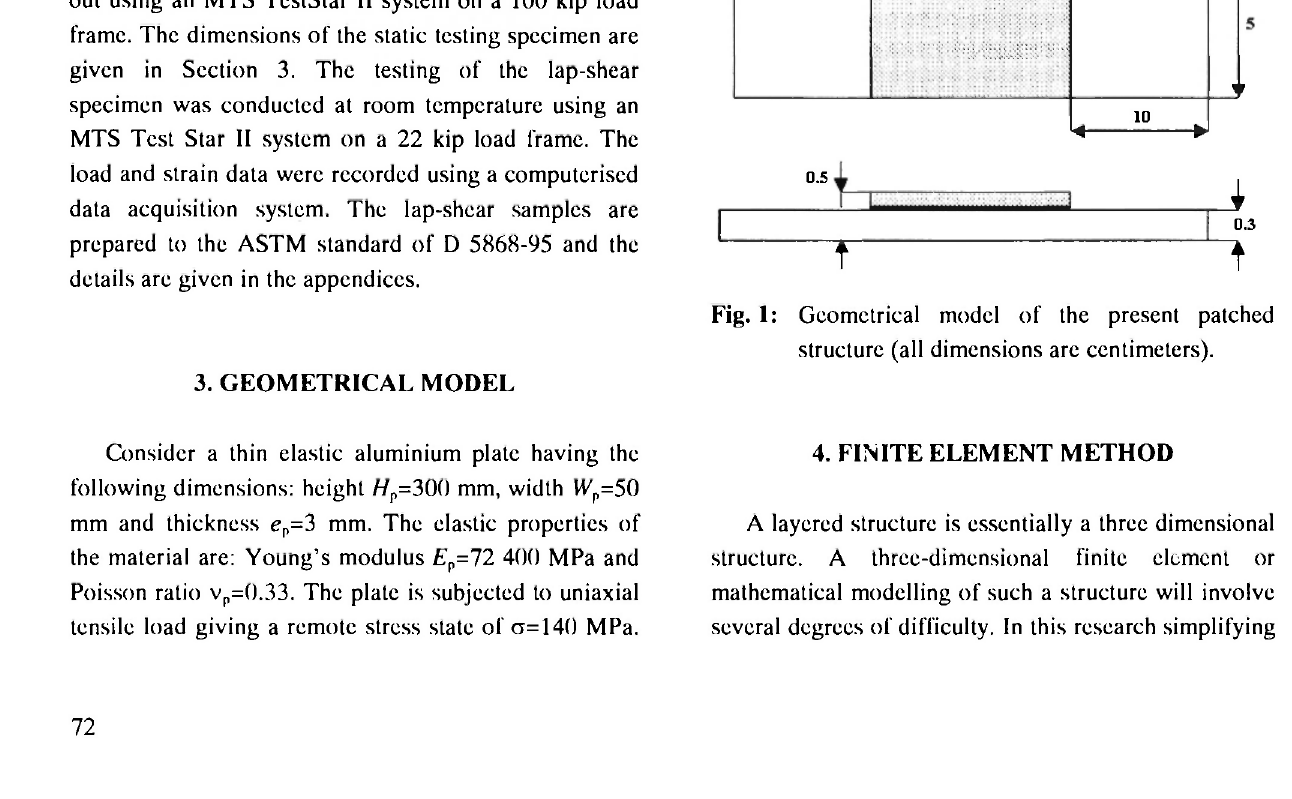
Fig. 1: Geometrical model of the present patched structure (all dimensions are